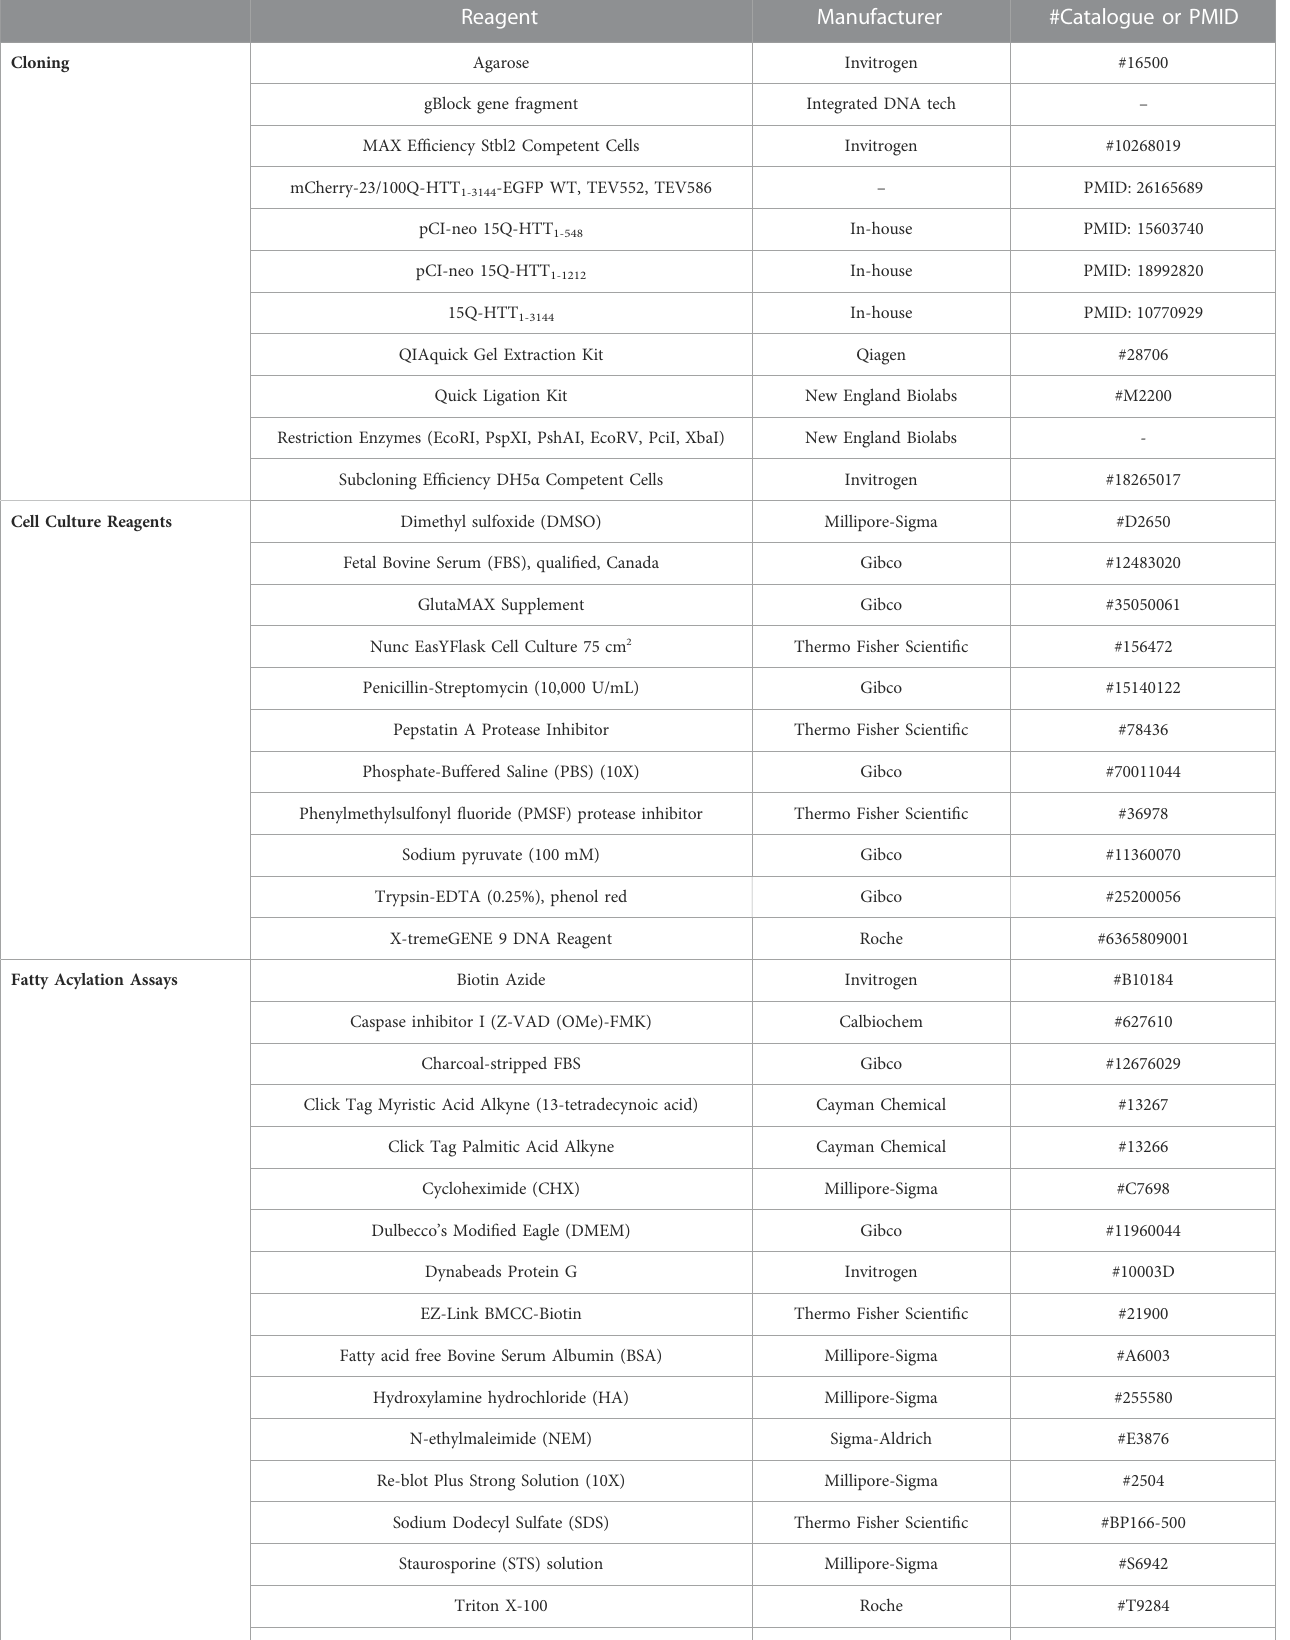
TABLE 1 List of reagents and chemicals